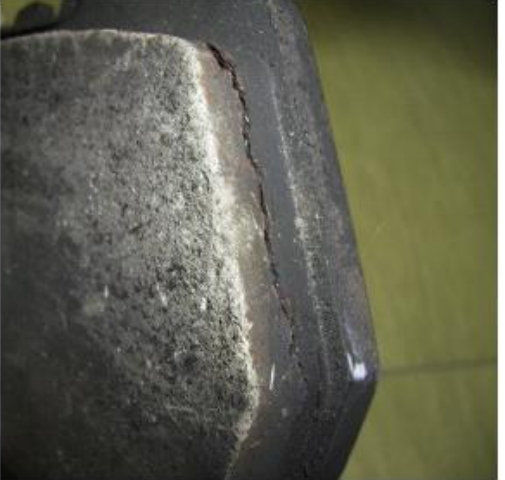
Figure 8. An example of a “distorted” disk brake pad as a result of high temperature and excessive load (reprinted/adapted with permission from ref. [13]. 2022, Elsevier)